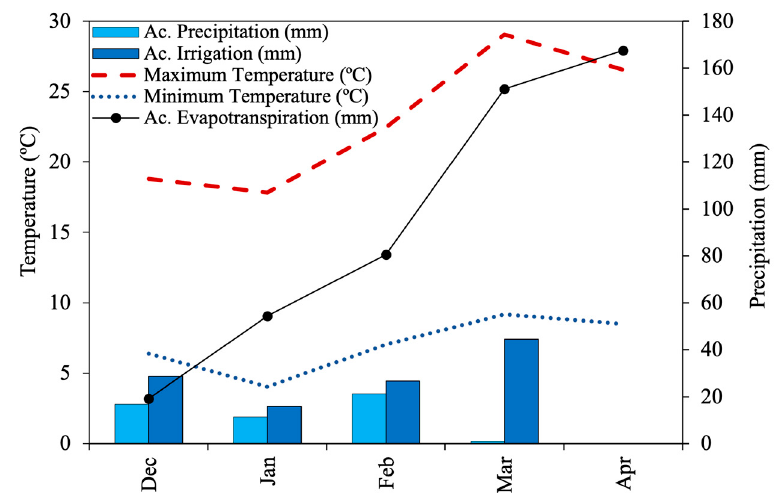
Figure 1. Monthly accumulated rainfall (cyan bars), irrigation (blue bars), evapotranspiration (closed circles, plain lines), and mean maximum and mean minimum temperatures (dashed and dotted lines, respectively) during the growing season from sowing until harvesting for biomass measurement (3–4 April 2017). Evapotranspiration during April refers only to the days until harvest.